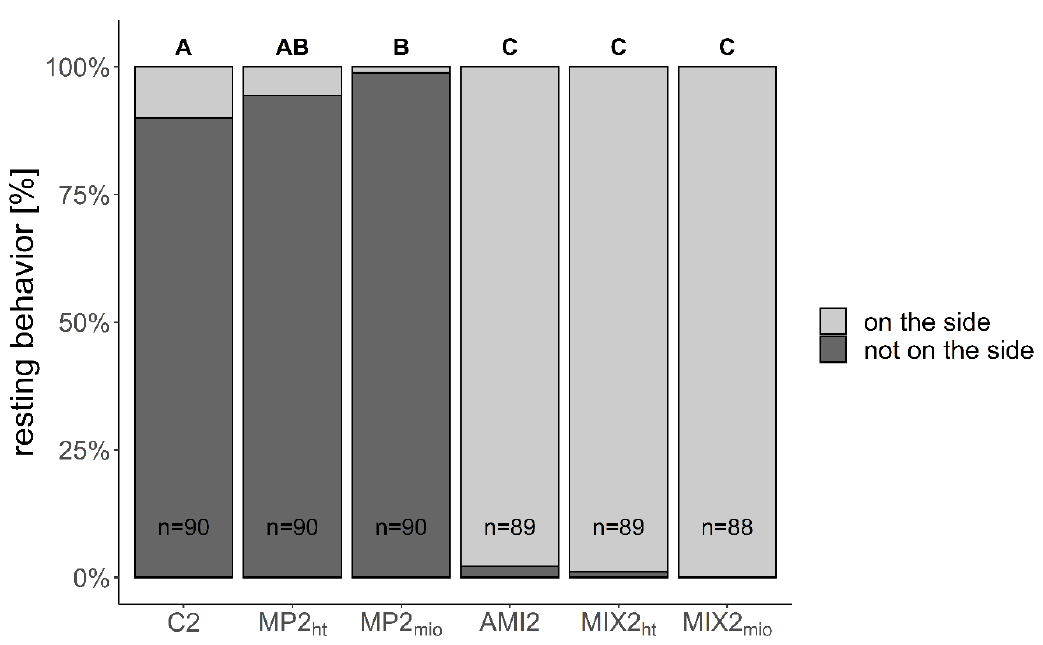
Figure 5. Resting behavior of brown trout fry after 42 days after exposure. Compared to the control significantly less fish exposed to MP2 mio are resting on their side while significantly more fish exposed to amitriptyline (AMI2) or the mixture of amitriptyline and MP (MIX2 ht and MIX2 mio ) are resting on their side ( Χ 2 = 604.0806, d.f. = 5, p < 0.0001, C2/MP2 ht : p = 0.4048, C2/MP2 mio : p = 0.01816, MP2 ht /MP2 mio : p = 0.2108, C2/AMI2, C2/MIX2 ht , C2/MIX2 mio , MP2 ht /MIX2 ht and MP2 mio /MIX2 mio p < 0.001, AMI2/ MIX2 ht and MIX2 ht /MIX2 mio : p = 1, AMI2/ MIX2 mio : p = 0.4972). Different letters indicate significant differences.